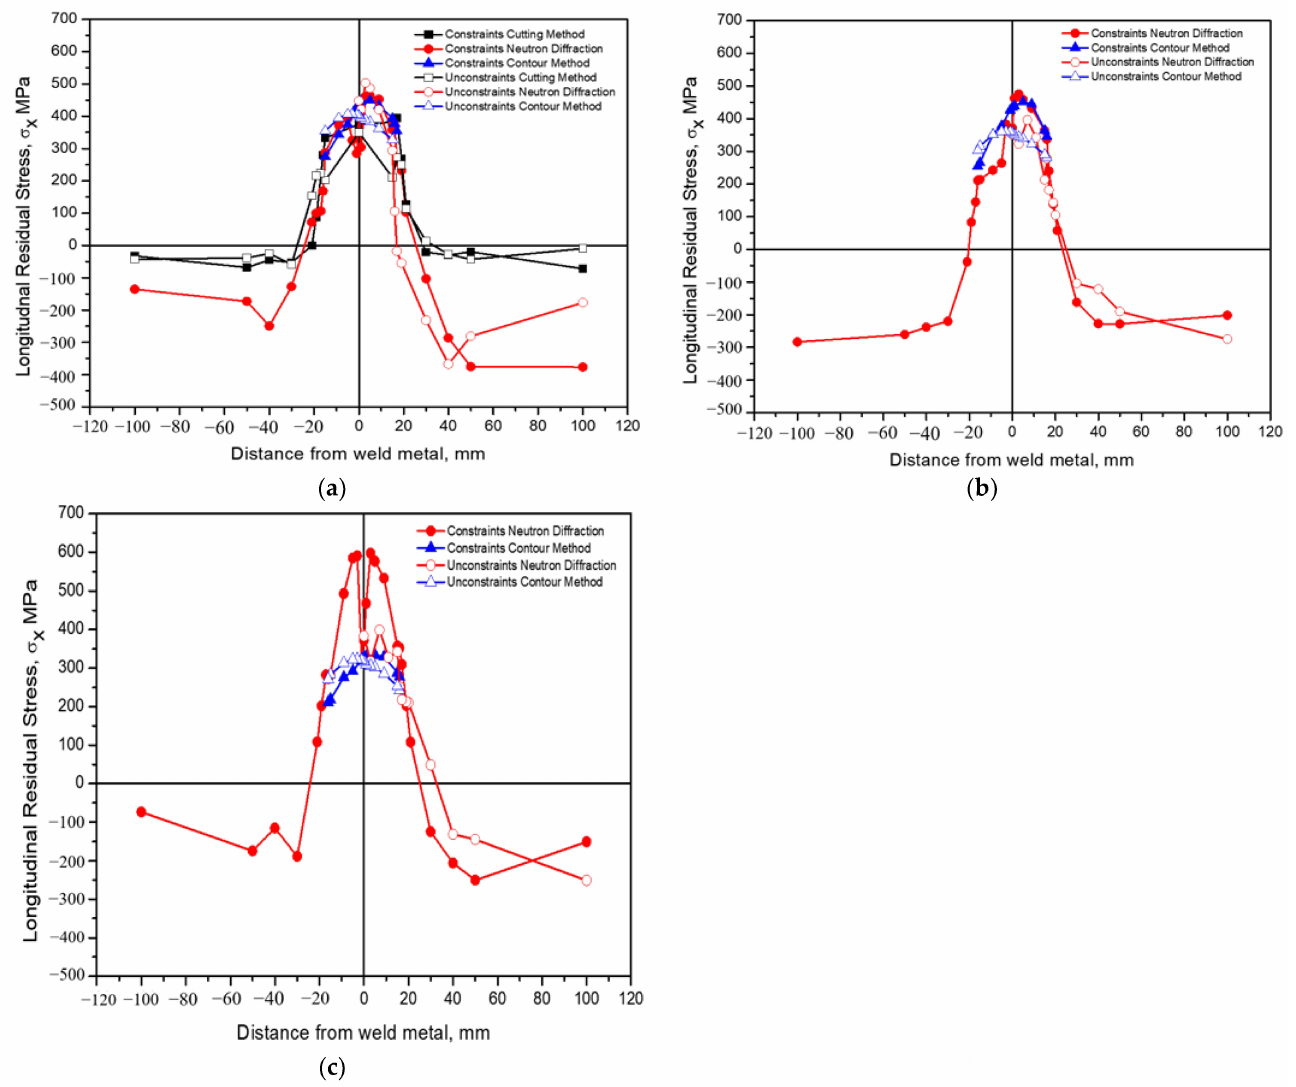
Figure 9. Weld residual stress σ x of face + 3, 12.5, and 22 mm by cutting, contour, and neutron diffraction methods. ( a ) Face + 3 mm; ( b ) face + 12.5 mm; ( c ) face + 22